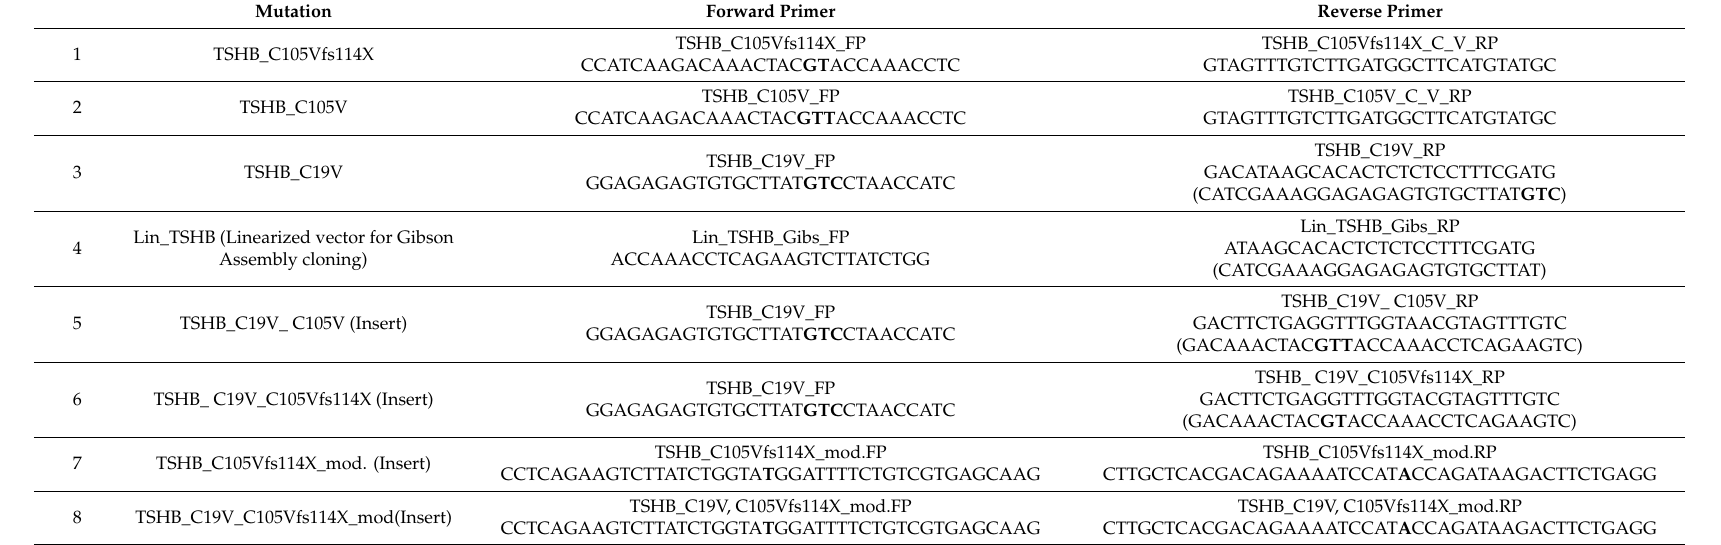
Table 1. Table of the used primers for site-directed mutagenesis (bold letters indicate site of mutagenesis; mutation names including signal peptide). Mutation Forward